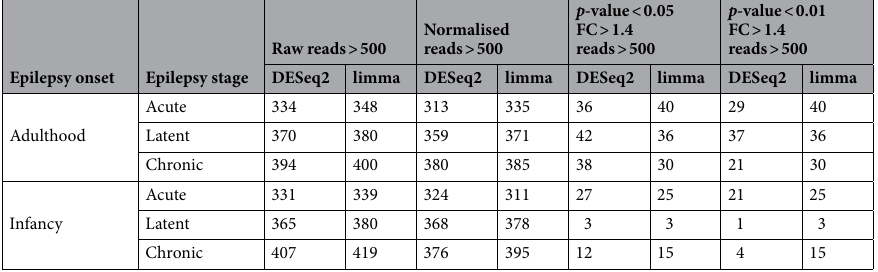
Table 1. Counts of miRNAs identified DESEq2 and limma . Descriptive results of two workflows of massive parallel sequencing data processing: DESeq2 and limma . The table contains count of miRNAs reaching threshold of 500 reads (both raw and normalised) in each statistical analysis. Counts of miRNAs with fold- change over 1.4, p -value below 0.05 or 0.01 and number of normalised reads above 500 are displayed for each stage of epileptogenesis in both age groups